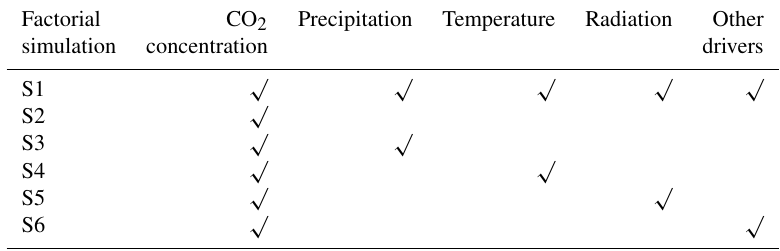
Table 1. List of factorial simulations used in this study. Factorial CO 2 Precipitation Temperature Radiation Other simulation concentration drivers √ √ √ √ √ S1 √ S2 √ √ S3 √ √ S4 √ √ S5 √ S6